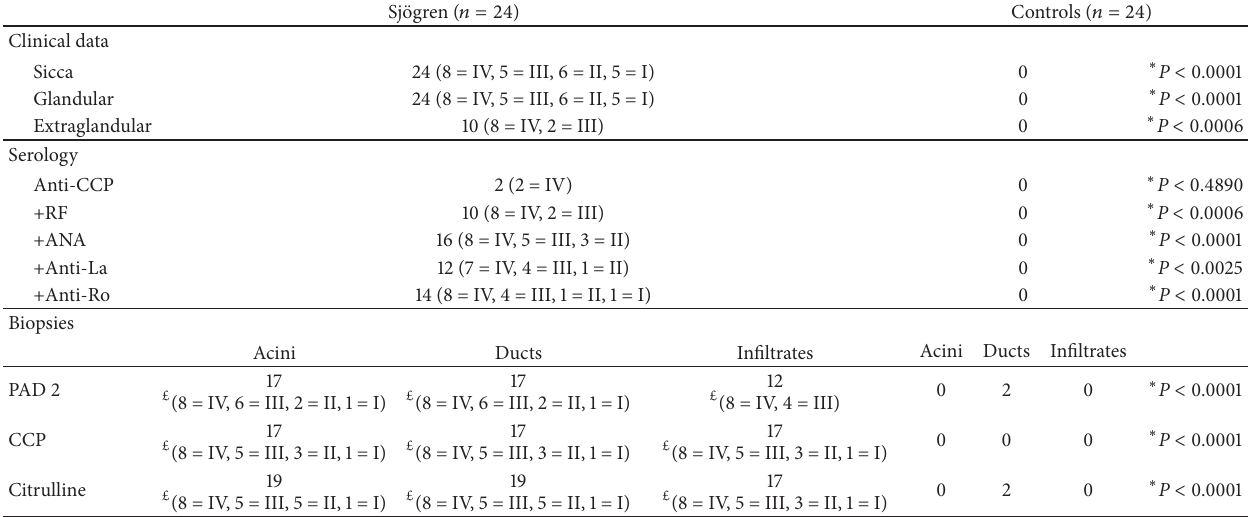
Table 1: Clinical, serologic, and immunohistochemistry